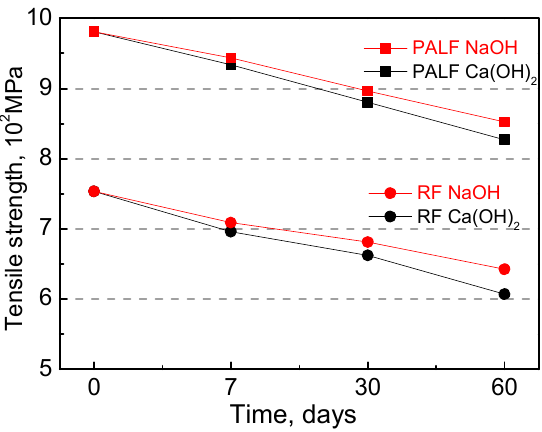
Figure 6. Tensile strength of natural plant fibers.